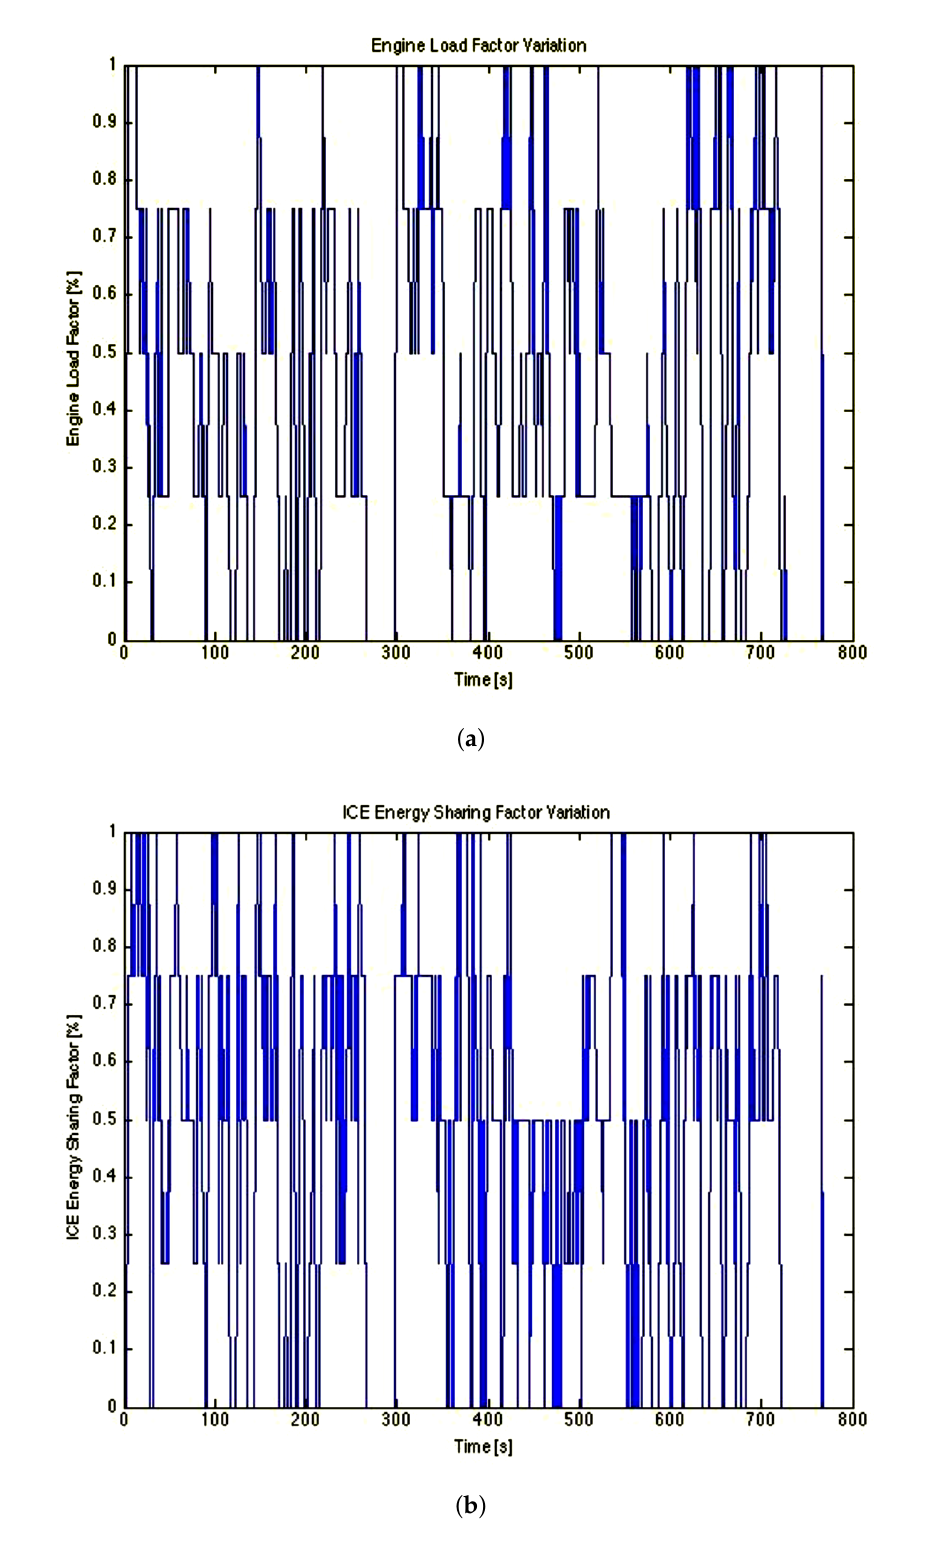
Figure 11. FHDS driving cycle. ( a ) ICE load factor; ( b ) ICE energy sharing